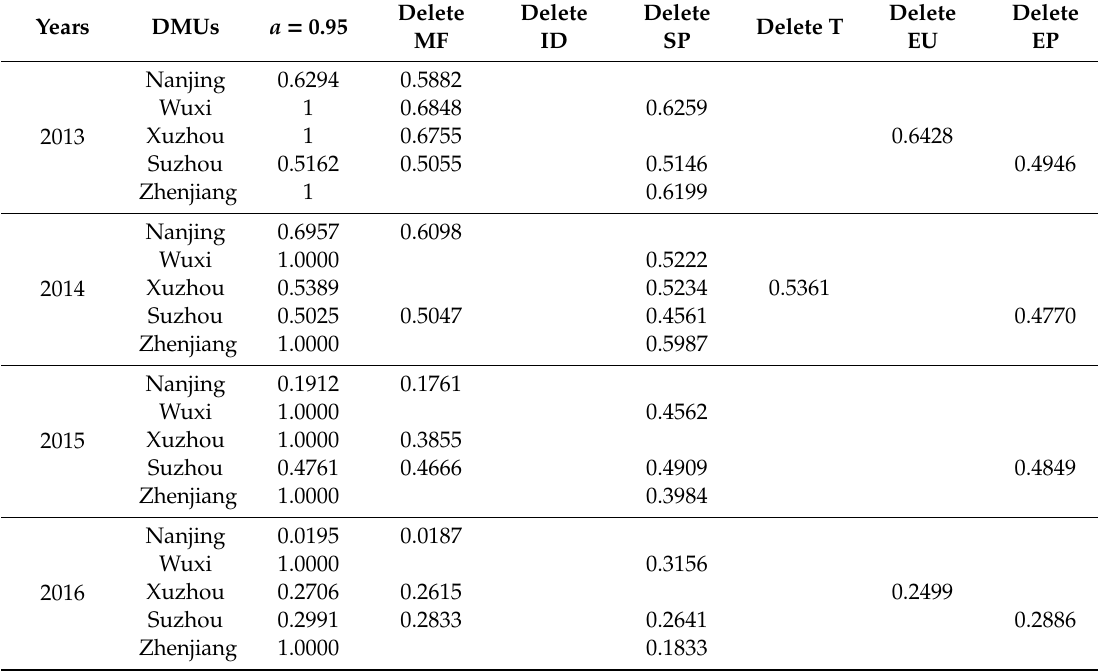
Table A8. The changes of stochastic e ffi ciency value by deleting grouping input variables in Southern Su ( α = 0.95).